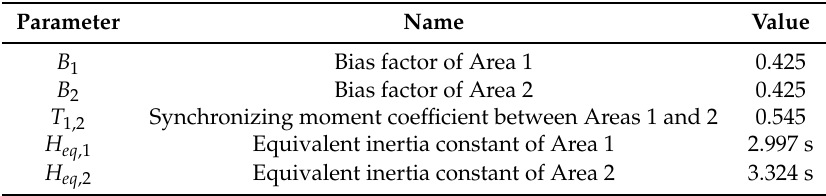
Table 4. Interconnected two-area power system parameters